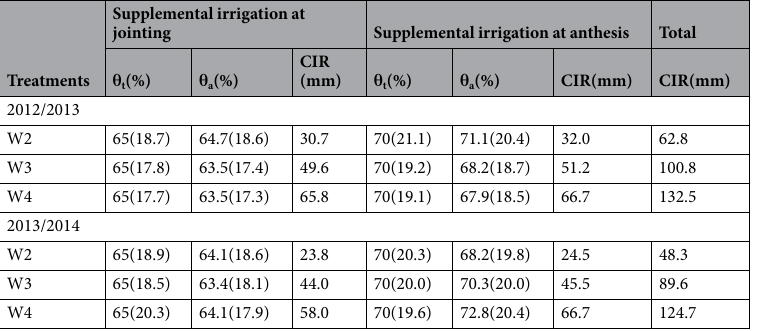
Table 1. The target relative soil water content ( θ t ) and actual relative soil water content ( θ a ) in the supplemental irrigation treatments (W2, W3 and W4) after jointing and anthesis in 2012/2013 and 2013/2014 growing season, the amount of supplemental irrigation (CIR) is also indicated. The treatments of W2, W3 and W4 were supplemental irrigation determined by measuring 0–20 cm, 0–40 cm and 0–60 cm soil layer moisture, respectively, and brought the soil moisture to 65% field water-holding capacity (FC) at jointing and 70% FC at anthesis. The data in the bracket are the soil water content by weight-base, which is calculated as relative soil water content multiples